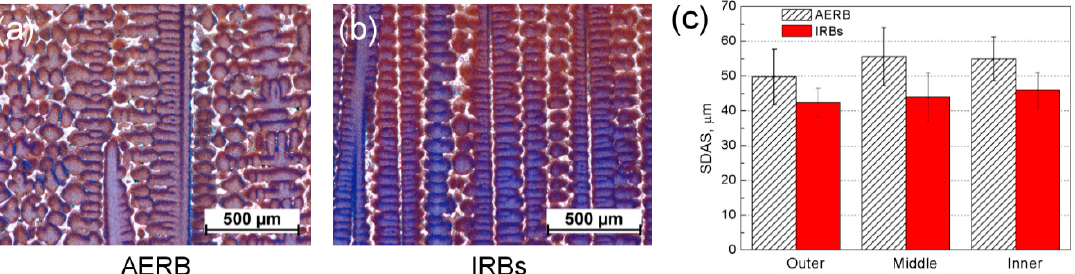
Figure 10. Example of dendritic microstructure ( a – f ) and primary dendrite arm spacing (PDAS) values ( g ) in outer ( a , d ), middle ( b , e ) and inner ( c , f ) area of cross-section placed at casting height of 100 mm for the process with use of adjusted external radiation baffle (AERB) ( a – c ) and inner radiation baffles (IRBs) ( d – f ).